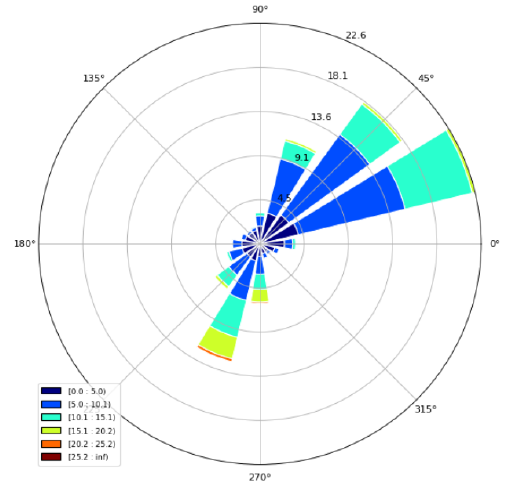
Figure 3. Comparison of wind speed and